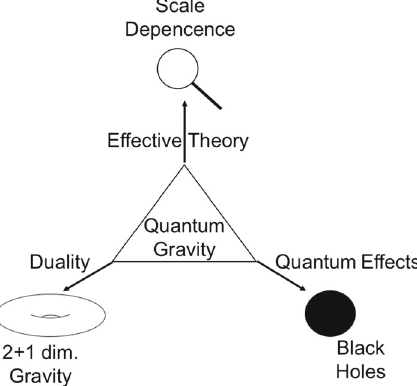
Fig. 1 Conceptual flow chart for the interplay of SD, BHs, and 2 + 1 dimensions with